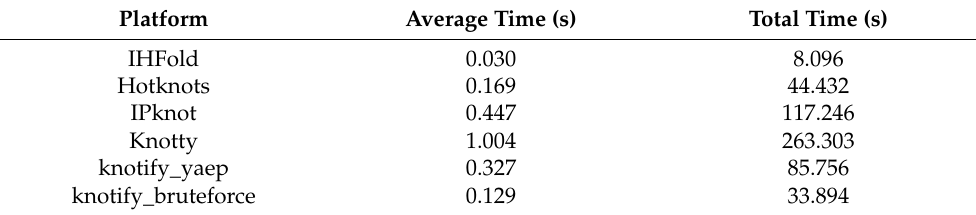
Table 10. Execution time required per platform in entire dataset.